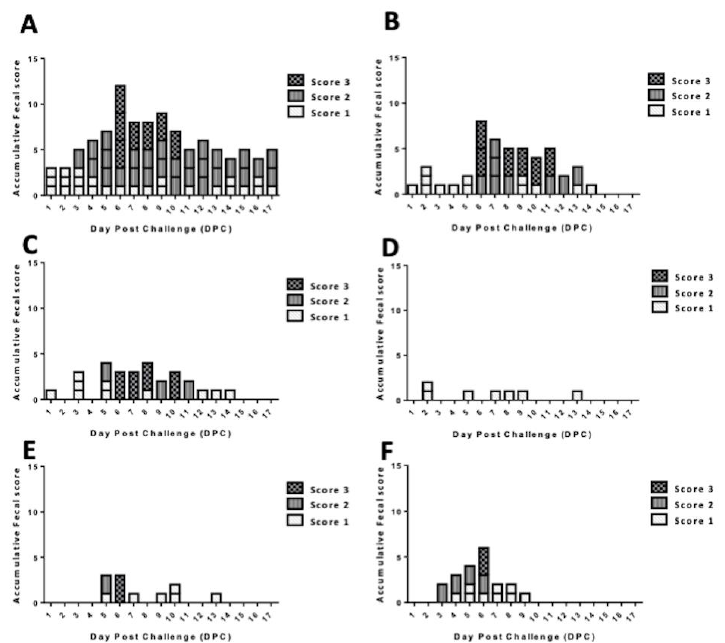
Figure 6. The accumulative scores of fecal conditions in ( A ) the mock group, ( B ) the iPEDV group, ( C ) the iPEDV + CCL28 group, ( D ) the iPEDV + CCL25 / 28 group, ( E ) the iPEDV + CCL25 / 27 group, and ( F ) the iPEDV + CCL25 / 27 / 28 group. The clinical signs of feces are classified into four grades: score 0, normal; score 1, loose; score 2, semi-fluid; and score 3, watery diarrhea.